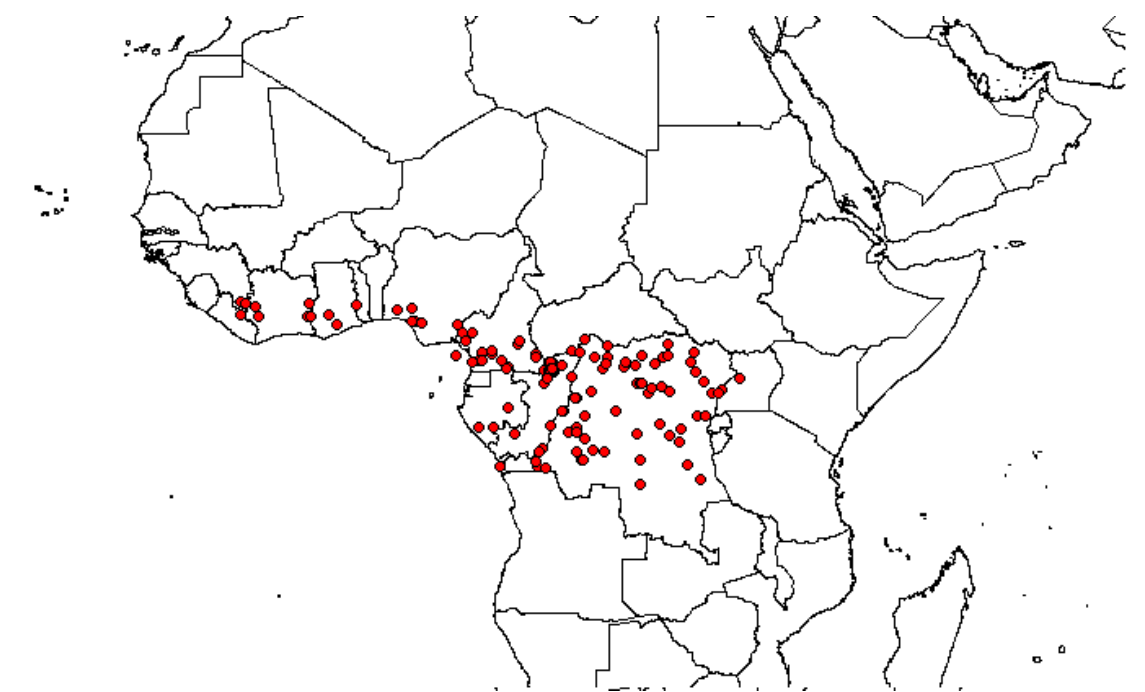
Fig. 7. Distribution map for Desplatsia dewevrei (De Wild. & T.Durand)